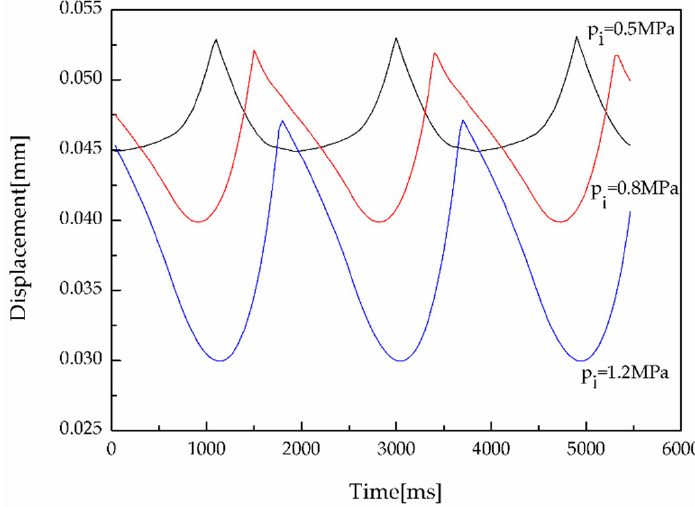
Figure 12. Displacement under dynamic load.